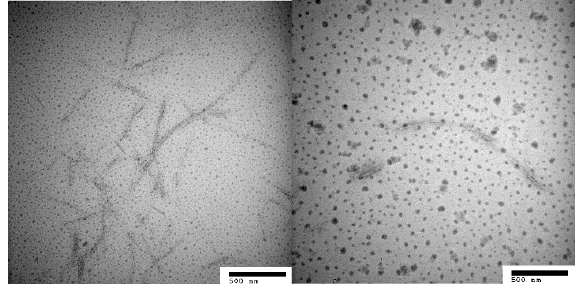
Figure 3. Transmission electron microscope images of CNF.